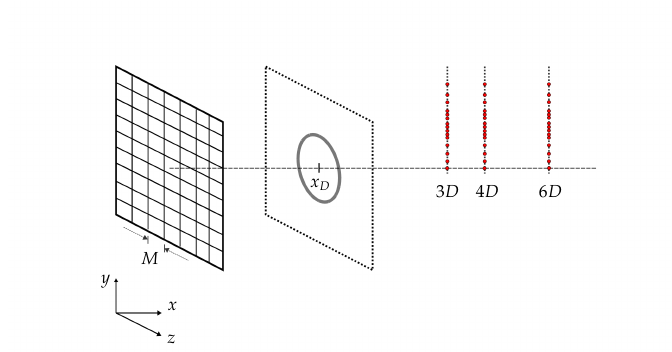
Figure 1. Representation of the measurement positions of the hot-wire. The turbulence is generated by a grid of spacing M . The reported values of TI are measured at x = 0.5 m from such grid, where the ADs are subsequently located. This position is referred to as x D . Time-series of the velocity are recorded at various positions along vertical lines at 3 D , 4 D and 6 D